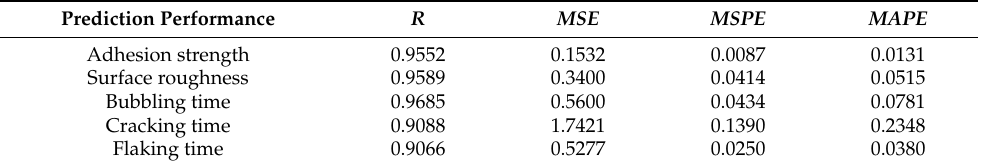
Table 4. The prediction performance of the remaining random samples obtained by the GA–BP